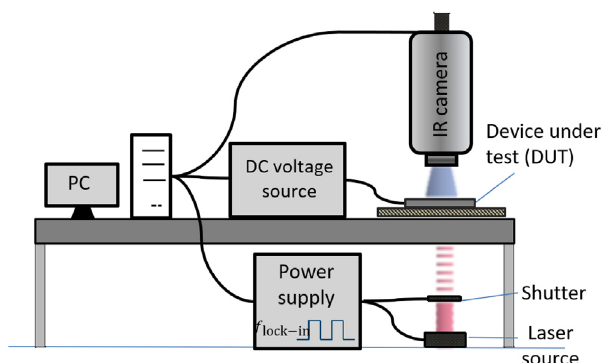
Fig. 1. Schematic image of LIT setup. The laser source is modulated using an optical shutter. The reversed biased voltage is applied in its